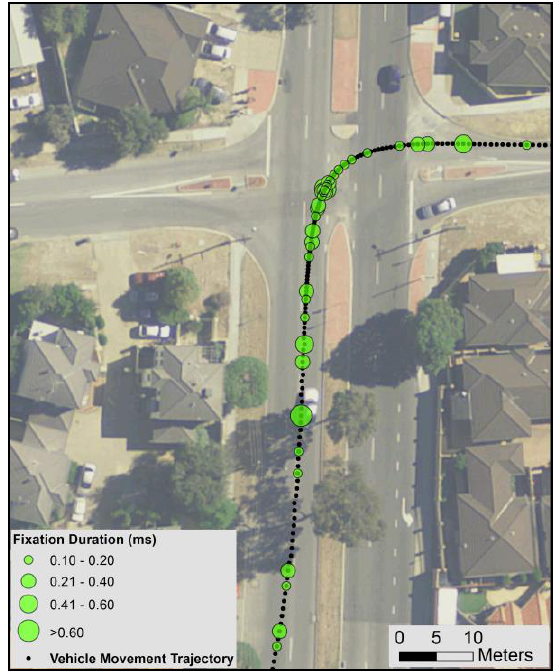
Figure 10. The driving manoeuvre at right-turn 1 and the eye fixation movement by an individual driver as an example. Selective attention is the visual ability to select the rel- evant information around the observers and to focus on the objects that require our attention. The results (Table 9) show older drivers’ selective attention to be negatively cor- related with the frequency of eye fixations at roundabout 5 and 6. These two roundabouts are of smaller size and lo- cated in-campus with a lot of surrounding buildings and trees, which can interfere with driving attention. The cor- relations indicate that older drivers with poorer selective attention took less eye fixations during these two rounda- bout manoeuvres. The positive correlations between selec- tive attention and the maximum duration parameter were found at roundabout 3 and 6. Overall, older drivers with lower capacity of selective attention performed less fre- quent of eye fixations at certain roundabout manoeuvres, they might have compensated with longer durations as their visual search